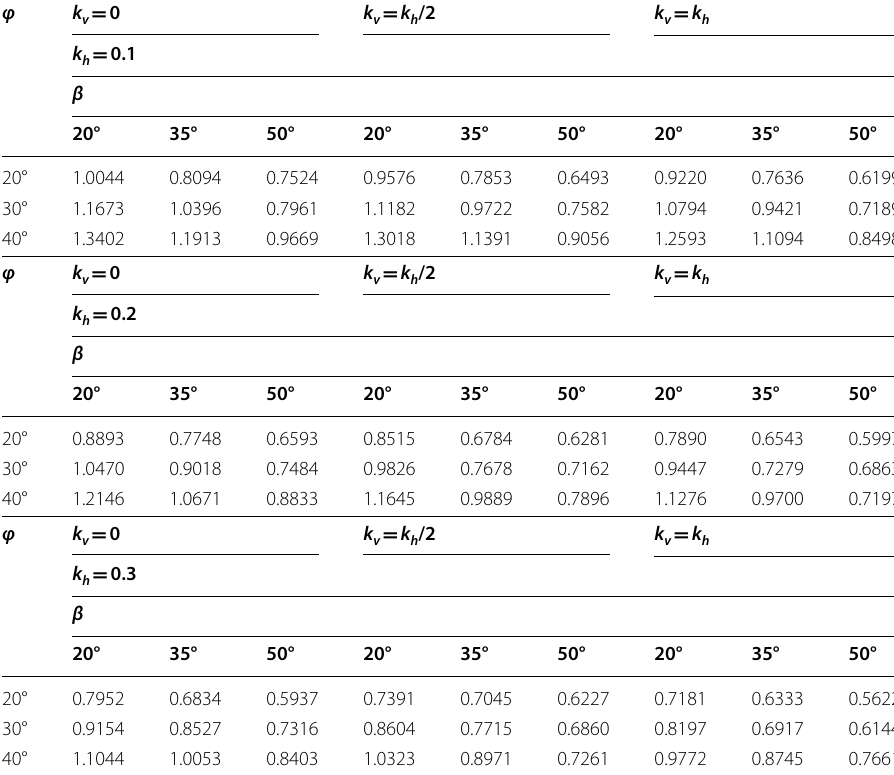
0.05 and q/γH 0 = = k h =